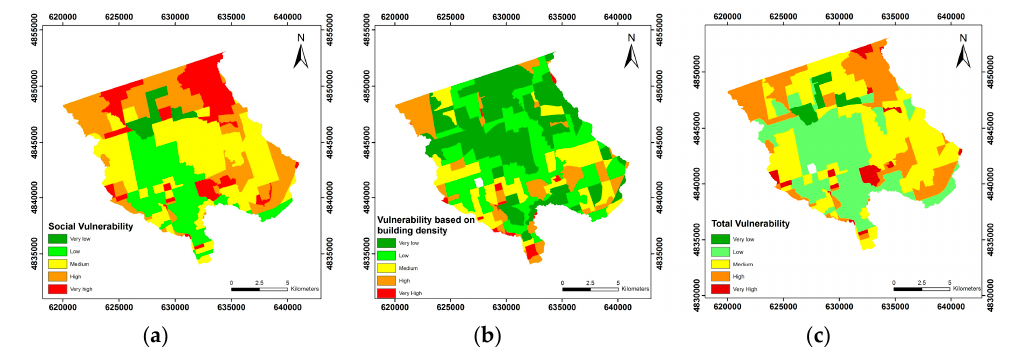
Figure 4. Vulnerability maps. ( a ) Social vulnerability map (low green Census Tracts (CT) reflects